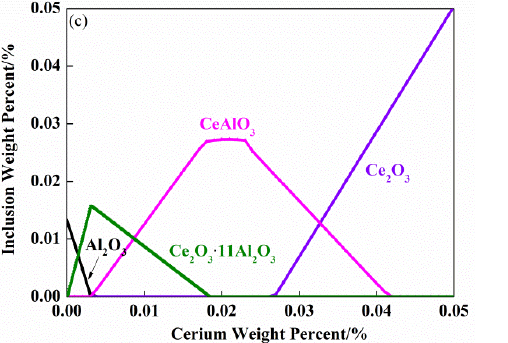
Figure 6. Evolution process of Al 2 O 3 inclusions when adding cerium at 1873 K. Calculations performed for ( a ) sample S2 steel composition; ( b ) sample S3 steel composition; ( c ) sample S4 steel composition.